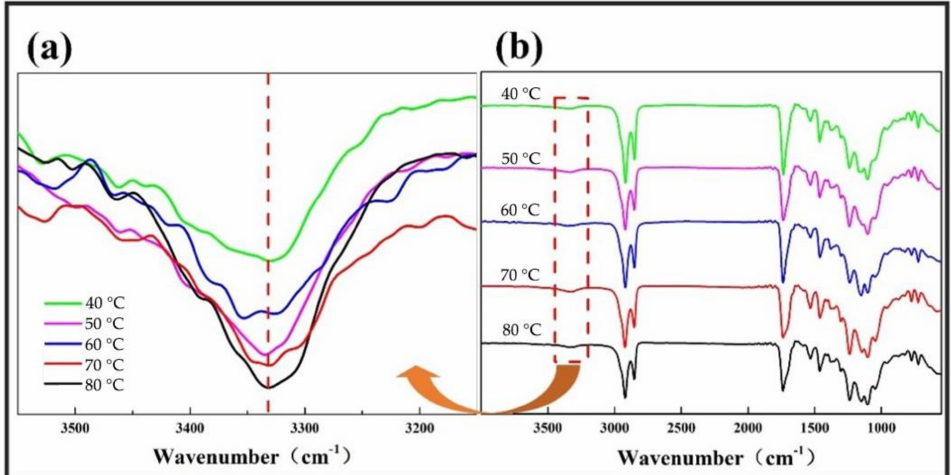
Figure 14. ( a ) FT-IR spectra of the N-H bonds of SPU films with different film forming temperatures, ( b ) FT-IR spectra of SPU films with different film forming